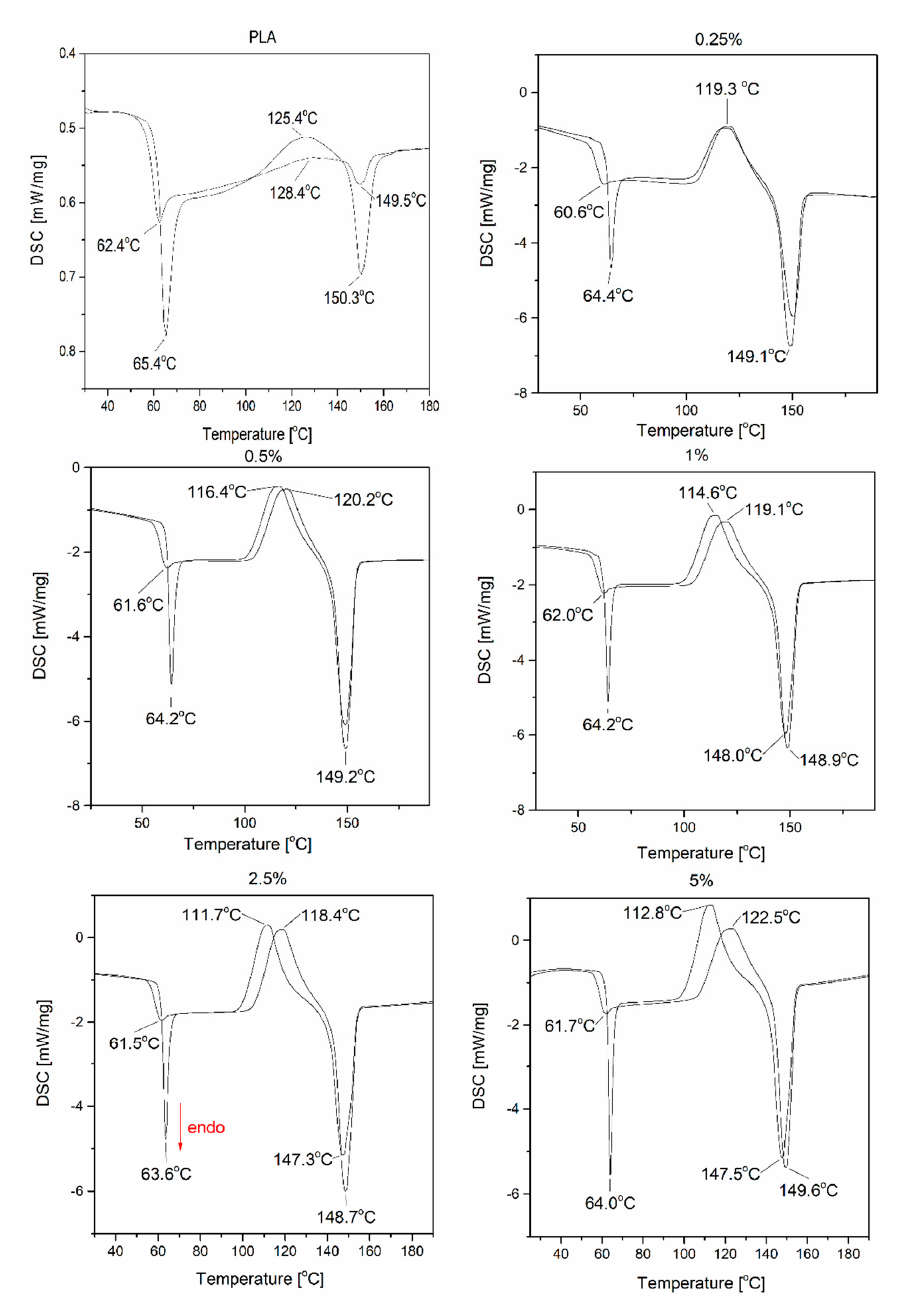
Figure 6. DSC curves recorded for samples of SS-Limonene / PLA